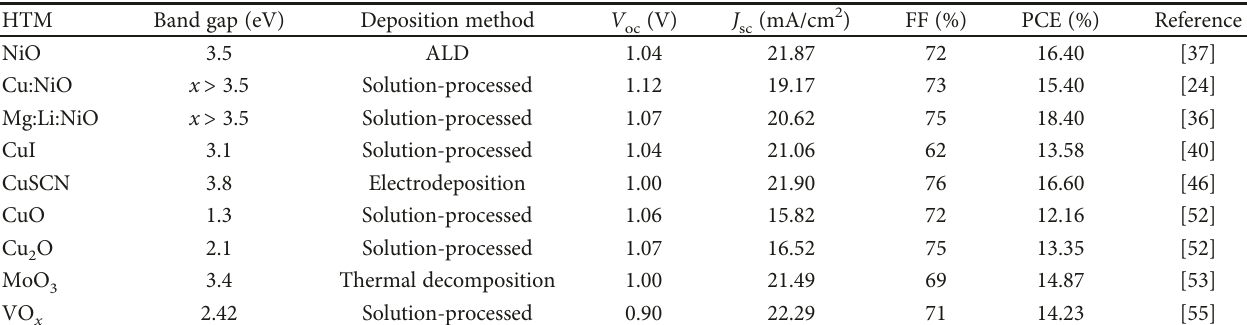
Table 1: Device parameters for high-performance organometallic lead halide perovskite solar cells (PSCs) based on di ff erent inorganic hole transport materials (HTMs), the band gap, and deposition method of these